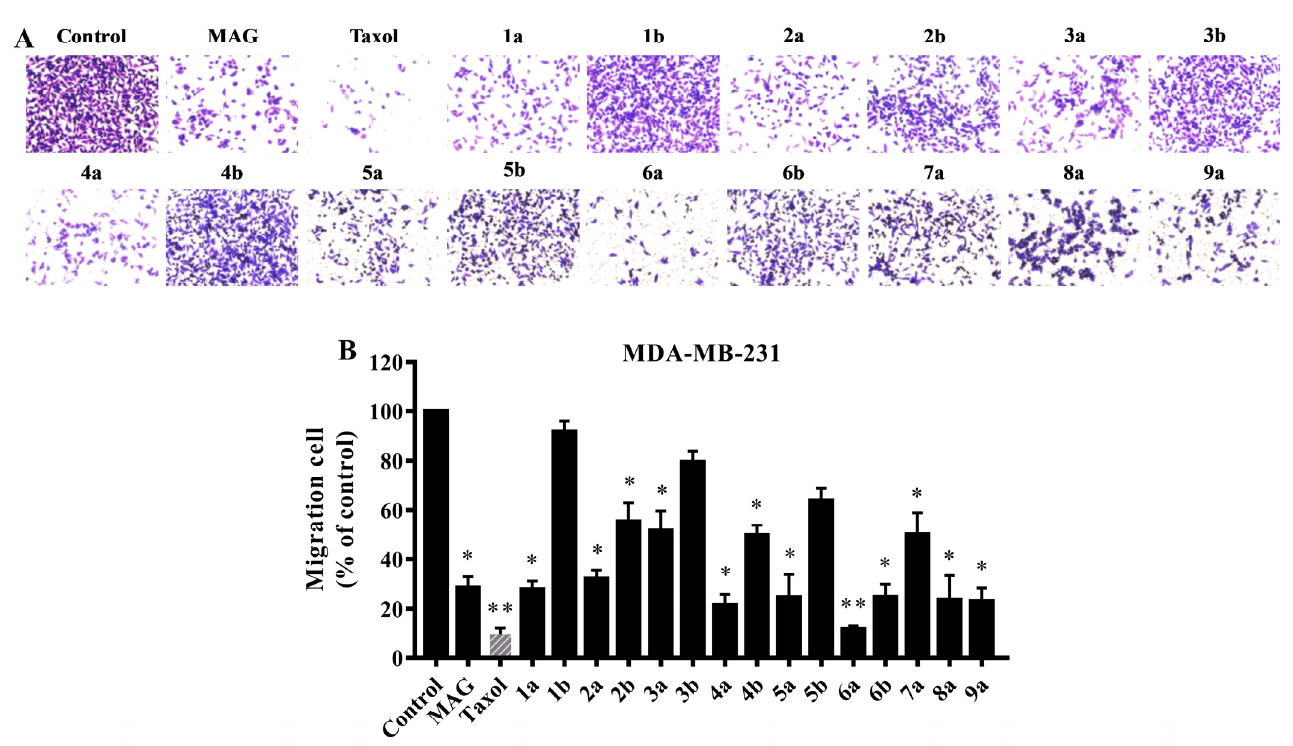
Figure 2. Preliminary screening of the effects of the MAG derivatives on the migration of MDA-MB-231 cells by a transwell assay. ( A ) MDA-MB-231 cells were seeded into the transwell chamber at a density of 5 × 10 4 cells per well and exposed to the MAG derivatives (10 µ M) for 24 h. Taxol was used as the positive control. The cells at the lower side of the membrane were then stained using crystal violet (original magnification 200 × ). ( B ) Quantification analysis presented as the mean ± standard deviation. * p < 0.05, ** p < 0.01 ( n = 3).